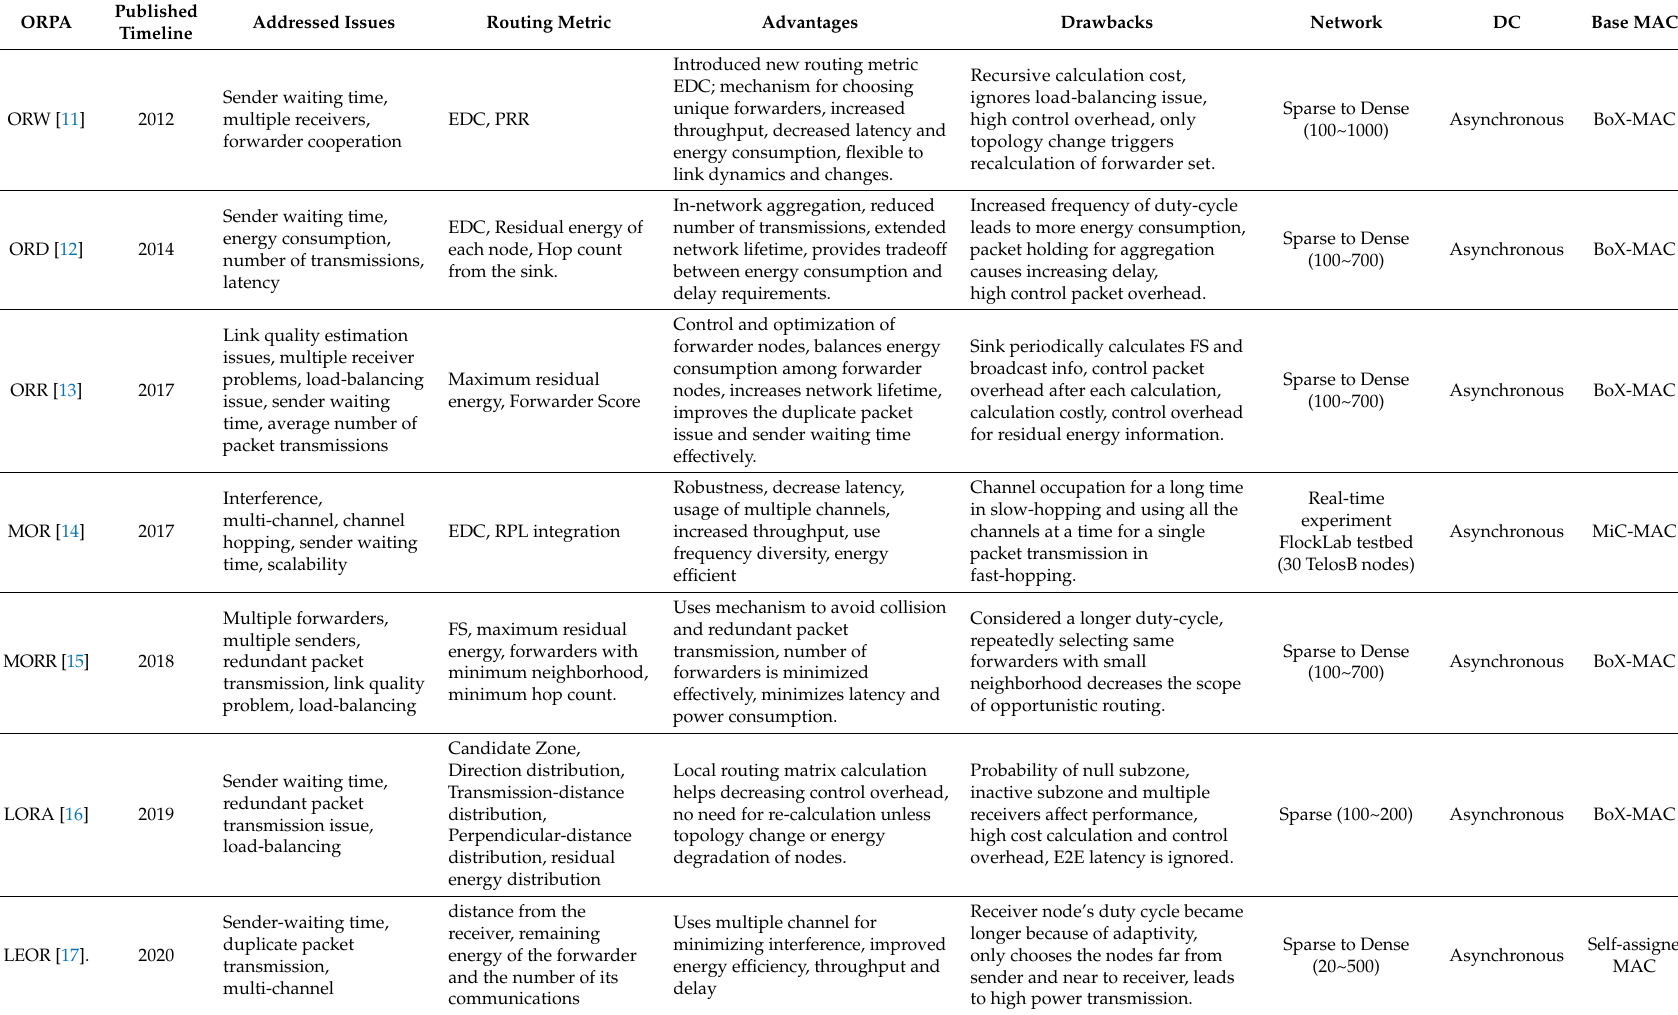
Table 2. Short review on opportunistic routing protocols with asynchronous duty-cycled MAC in